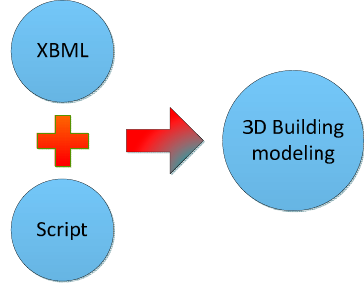
Figure 1. Pattern of the semantic modelling framework.